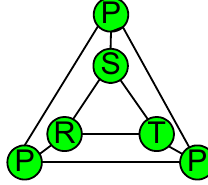
Figure 2. The global trusted dependability (GTD) architecture with distributed observers.